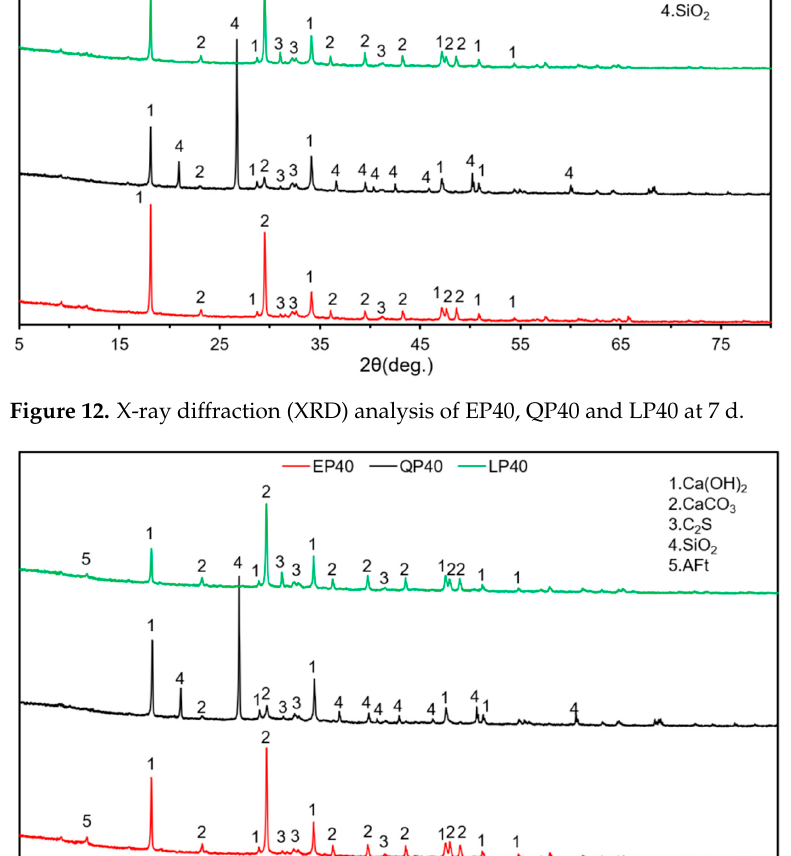
Figure 15. Thermal decomposition of EP40, QP40 and LP40 by TGA–DTG analyses at 28 d. 3.4.3. FTIR Analysis Figure 16 demonstrates the FTIR spectra of EP40, QP40 and LP40 at 7 and 28 d. The band at 3640 cm − 1 corresponds to the OH − group in Ca(OH) 2 [50]. Monocarboaluminate is related to the split ν 3-CO 32 − at approximately 1420 cm − 1 with ν 2-CO 32 − at approximately 880 cm − 1 . The intensity found between 900 and 1100 cm − 1 is associated with the formation of C–S–H [51]. The results obtained are consistent with those of XRD and TGA.